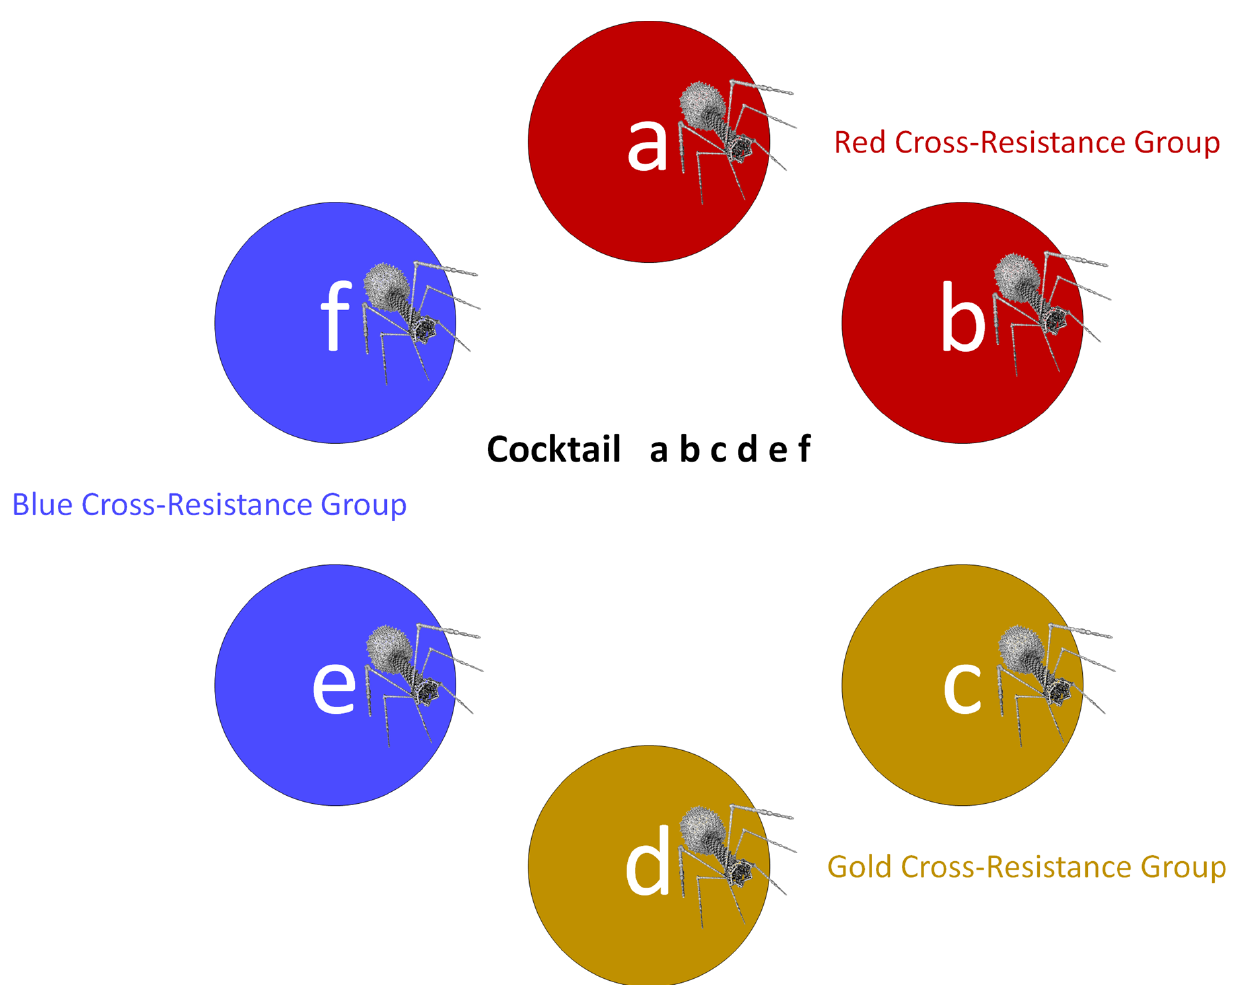
Figure 3. Combining phages found in both different and the same cross-resistance groups into a single phage cocktail. Phages a and b, c and d, and e and f are found within three different cross-resistance groups, red, gold, and blue, respectively. The presented cocktail, dubbed “a b c d e f”, consists of six phages and three cross-resistance groups, with constituent phages thus found overall in combinations of the same and different cross-resistance groups.